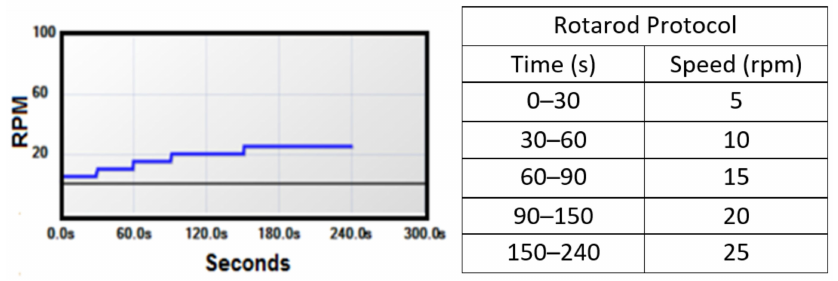
Figure 2. Rotarod motor function test protocol (rpm = rotations per